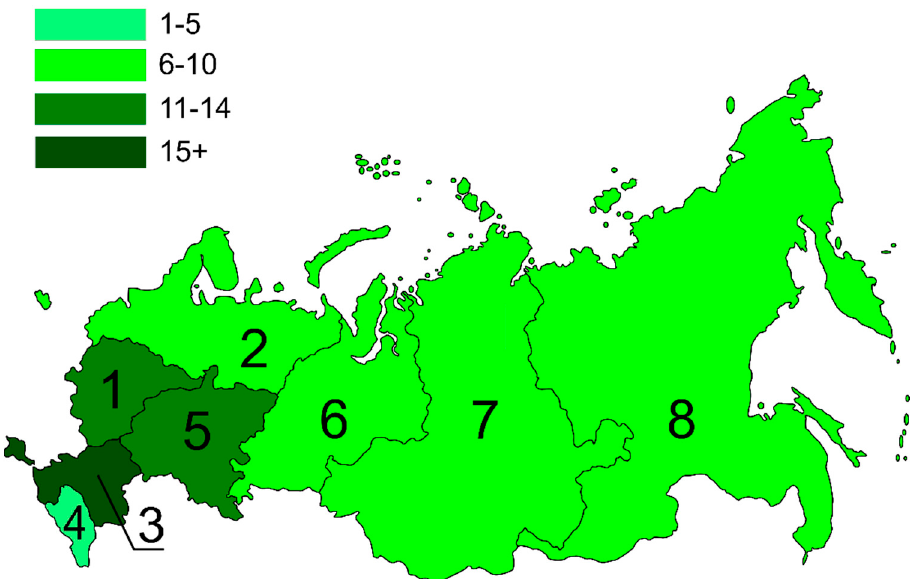
Figure 2. The map of the algal bloom outbreaks in Federal Districts of Russia in 2016–2018. The intensity of green color shows the relative number of algal blooms in the Federal District. Lines show the borders of the Federal Districts of Russia: 1—Central, 2—Northwestern, 3—Southern, 4—North Caucasian, 5—Volga, 6—Ural, 7—Siberian, 8—Far Eastern. Borders of the Federal Districts are shown as of 4 November 2018.